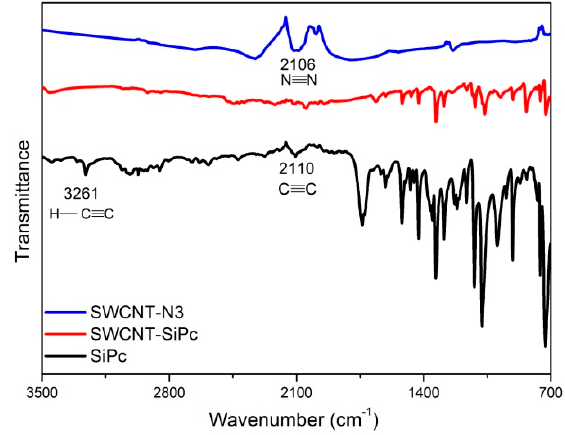
Figure 2. FT-IR spectra of SiPc, SWCNT-N3 and SWCNT/SiPc hybrid.